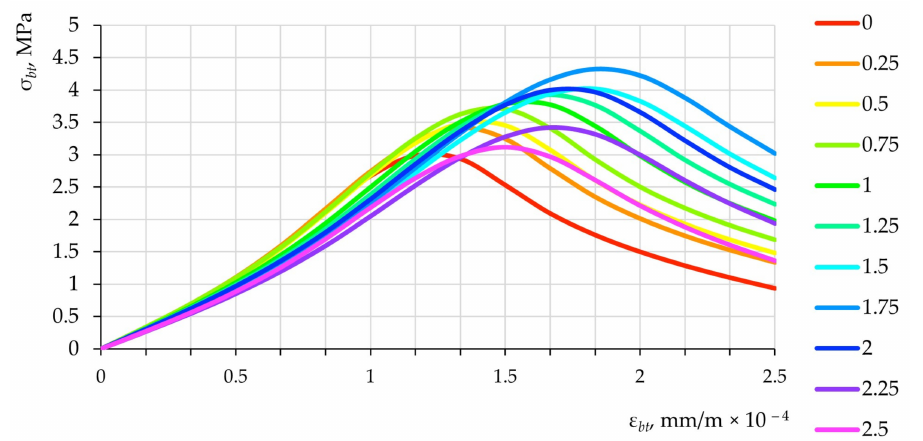
Figure 14. Stress–strain curves in compression.